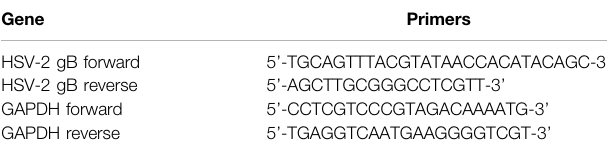
TABLE 3 | The sequences of primers for